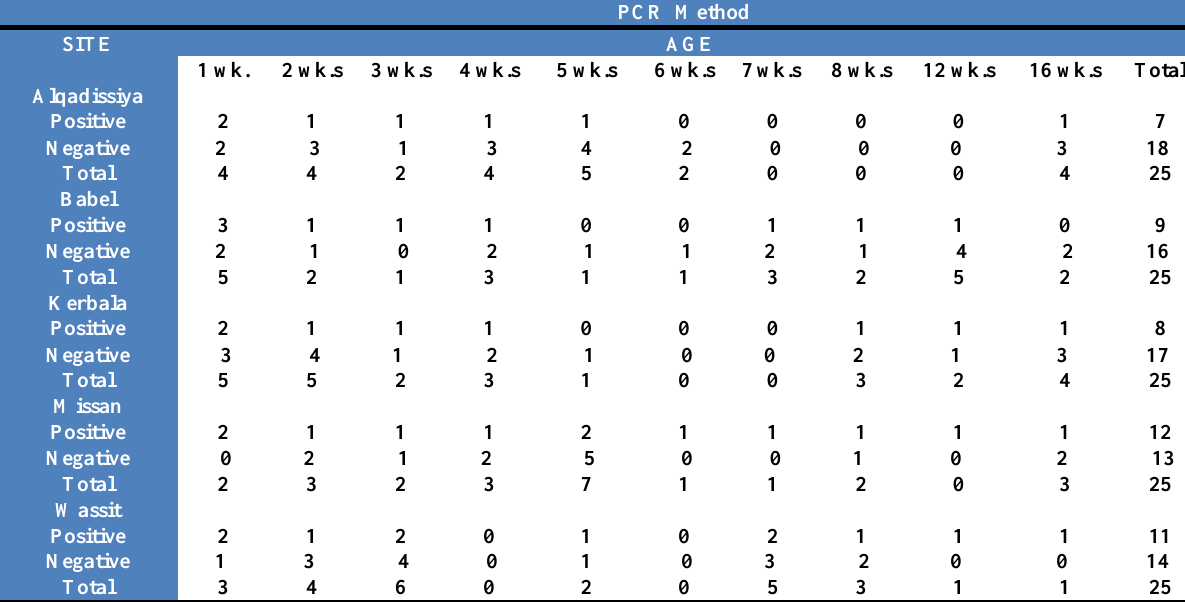
Table, 5: The results obtained by using Conventional PCR method for Rotavirus in 125 fecal samples according to age of tested